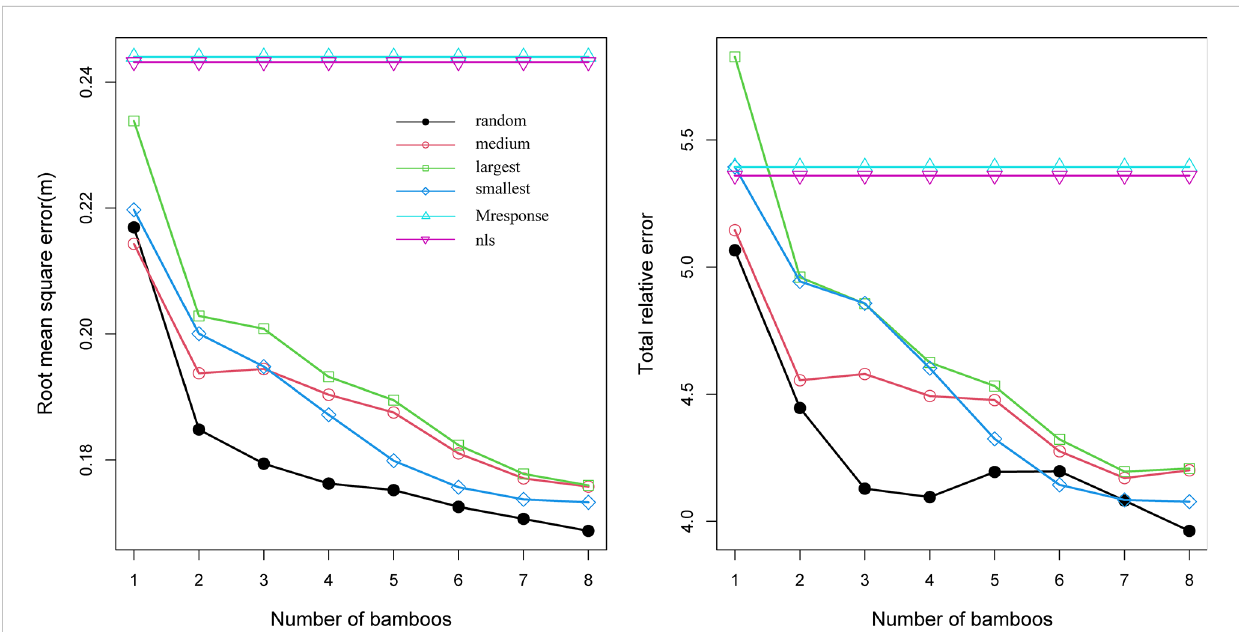
FIGURE 4 Root mean square error (RMSE) and total relative error (TRE) for the ordinary least squares (OLS) Model 18, Model 19 with the mean response (M response), and Model 18 with four sampling methods and sample sizes utilized within each sample plot, used to estimate the random effects (random: randomly selected DBH, largest: the largest DBH, medium: medium DBH, and smallest: the smallest